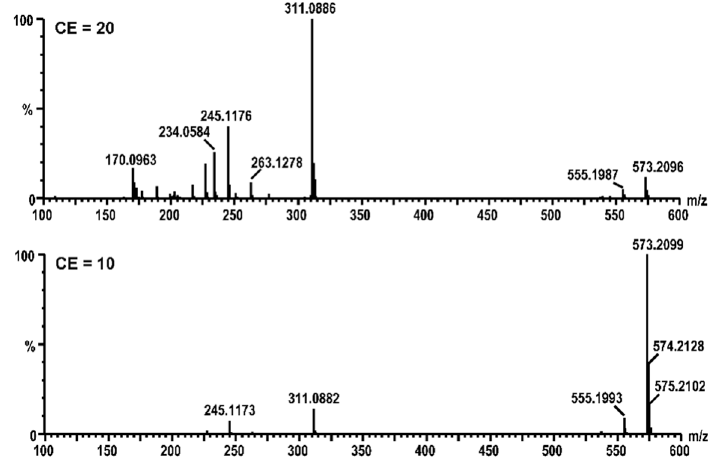
Figure 5. HPLC-MS/MS fragmentation profiles of the DCYA adduct having m/z 573 at different collision energies (CE).